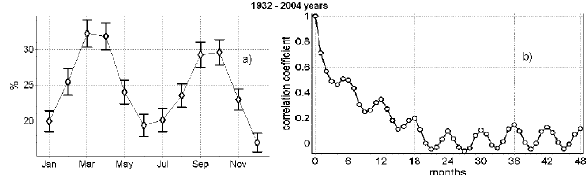
Fig. 4. Monthly mean A p -indices throughout the last 10 years and their forecasting.